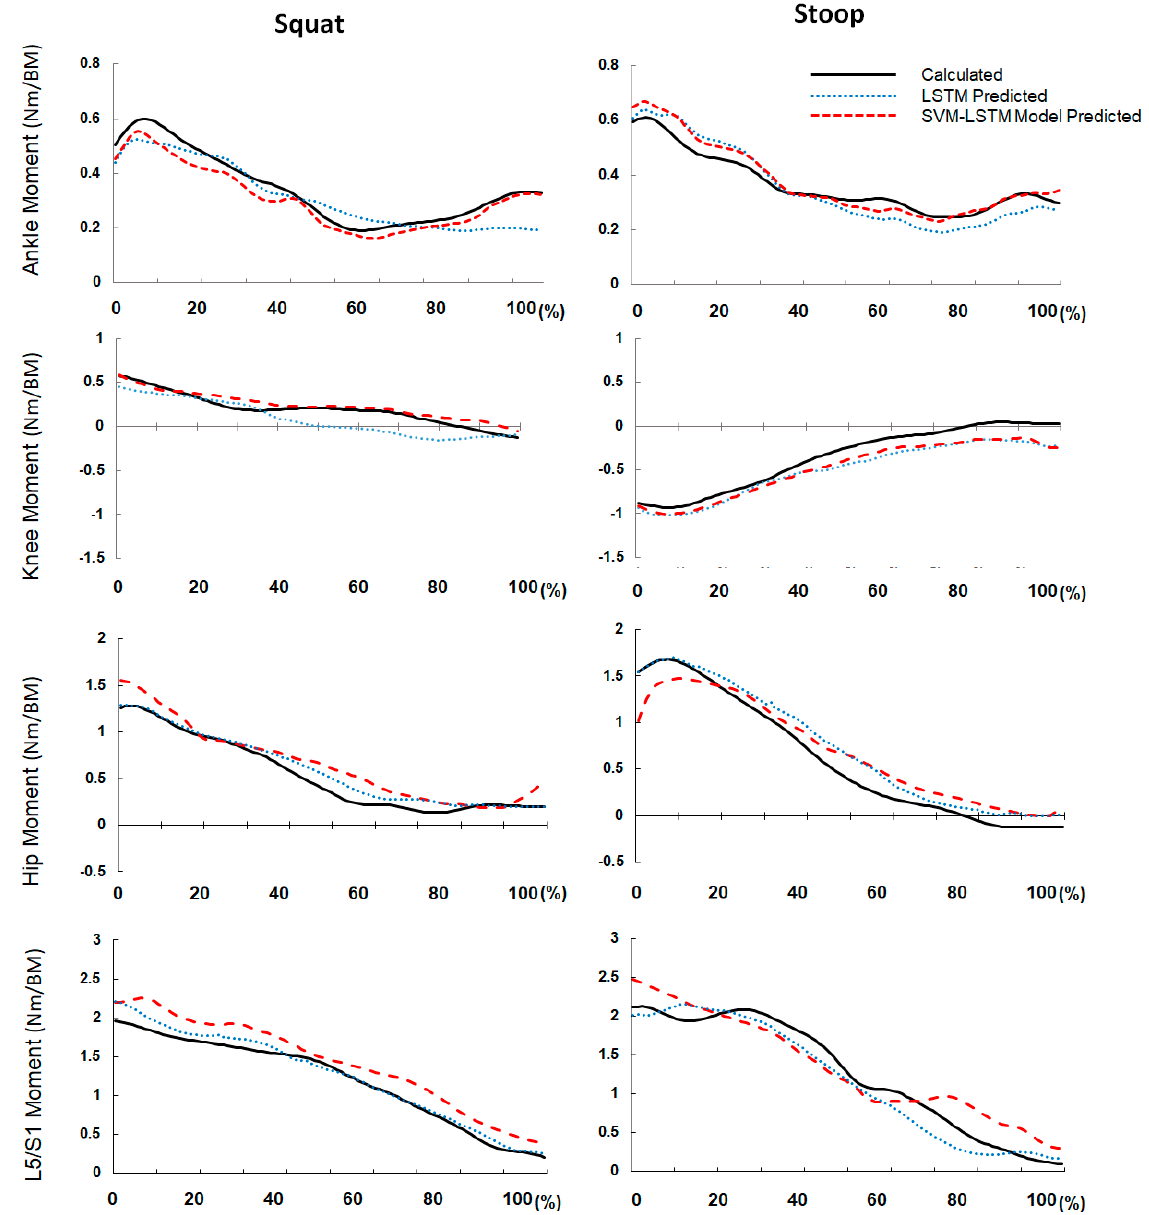
Figure 4. Representative results of lower extremities and L5/S1 joint moment prediction (ankle, knee, hip and L5/S1) from the reference system and the SVM-LSTM model.